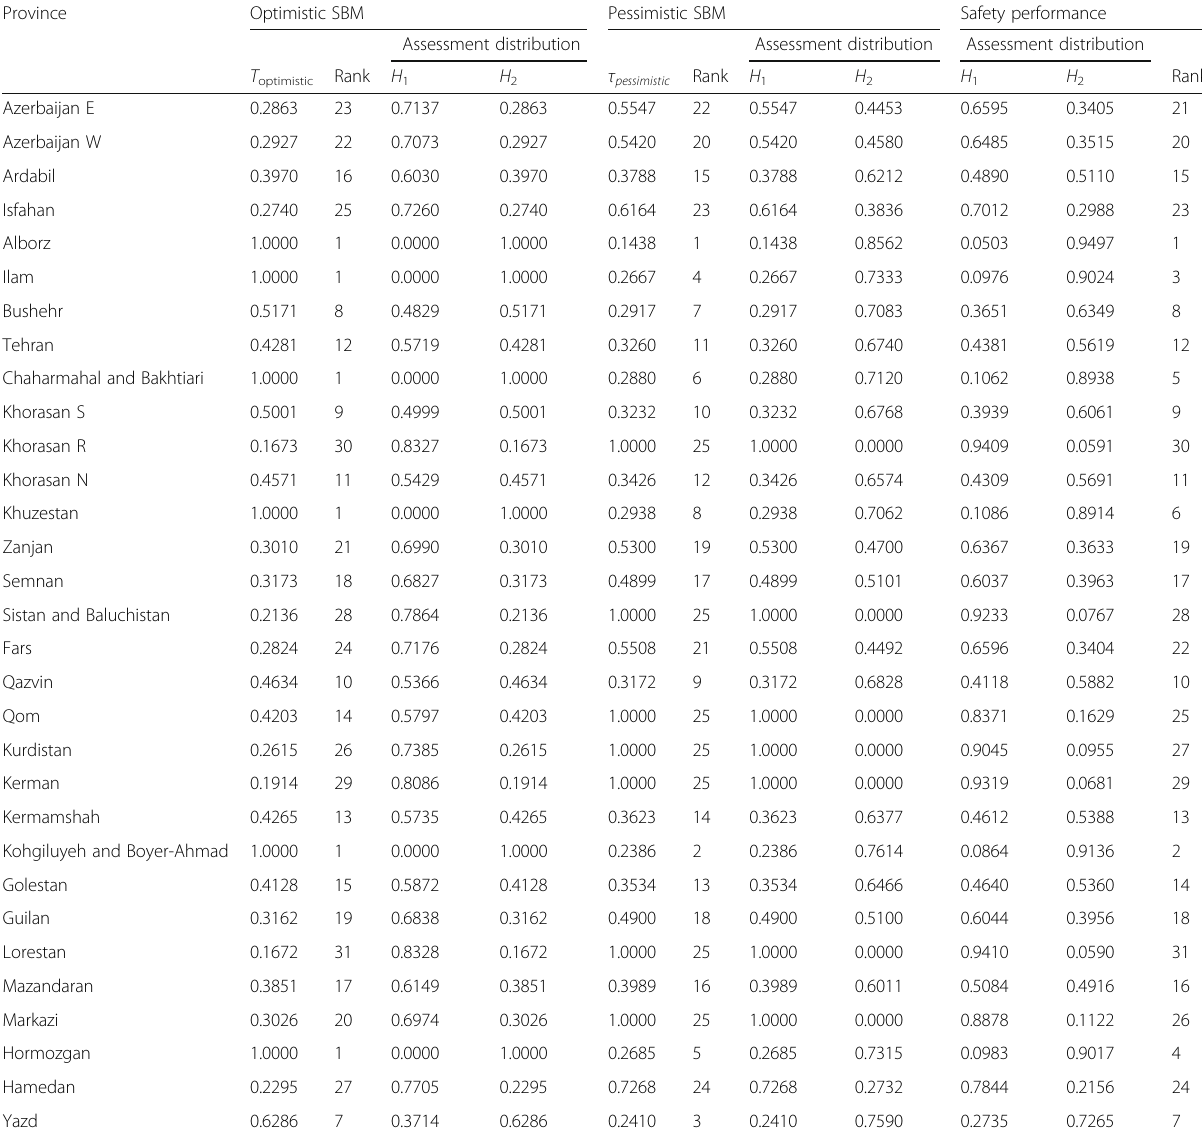
Table 4 Efficiency results for the 31 Iranian provinces in terms of road safety performance for the year 2015